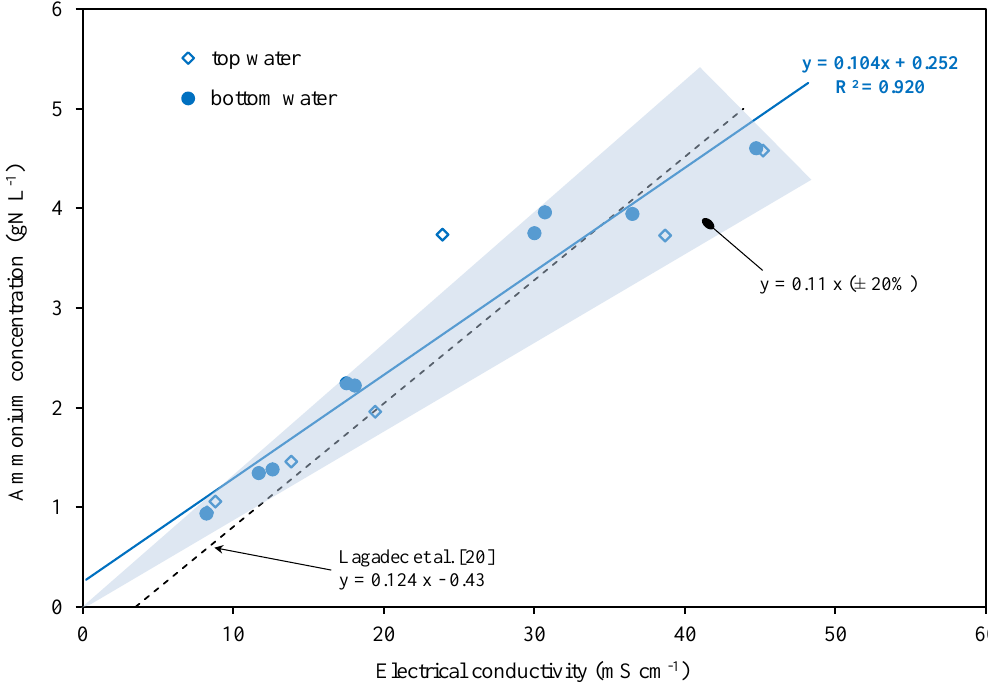
+ concentration in water